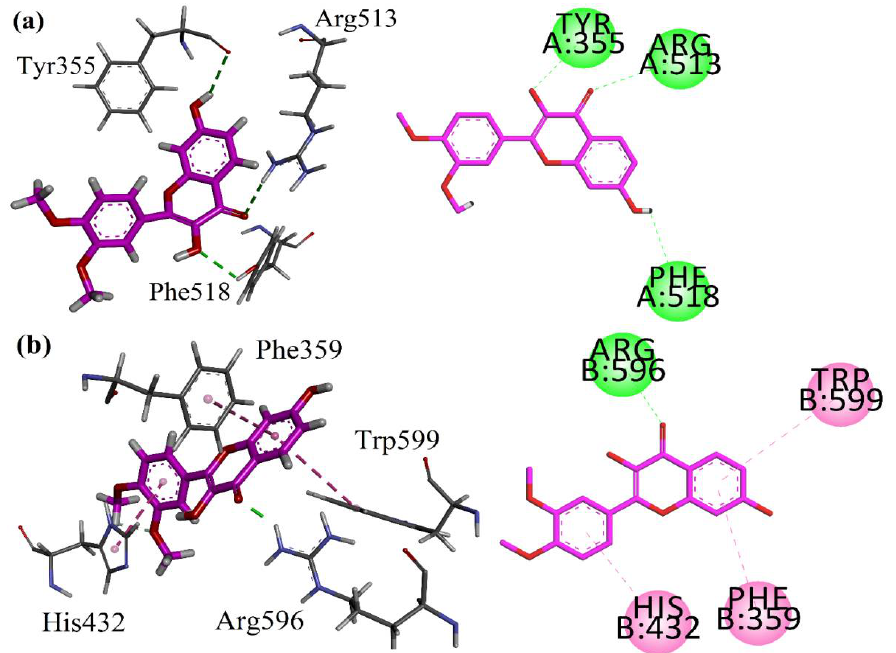
Figure 5. 3-D/2D interaction plots of compound in the binding sites of ( a ) COX-2 (PDB 1CX2) and ( b ) 5-LOX (PDB 6N2W).